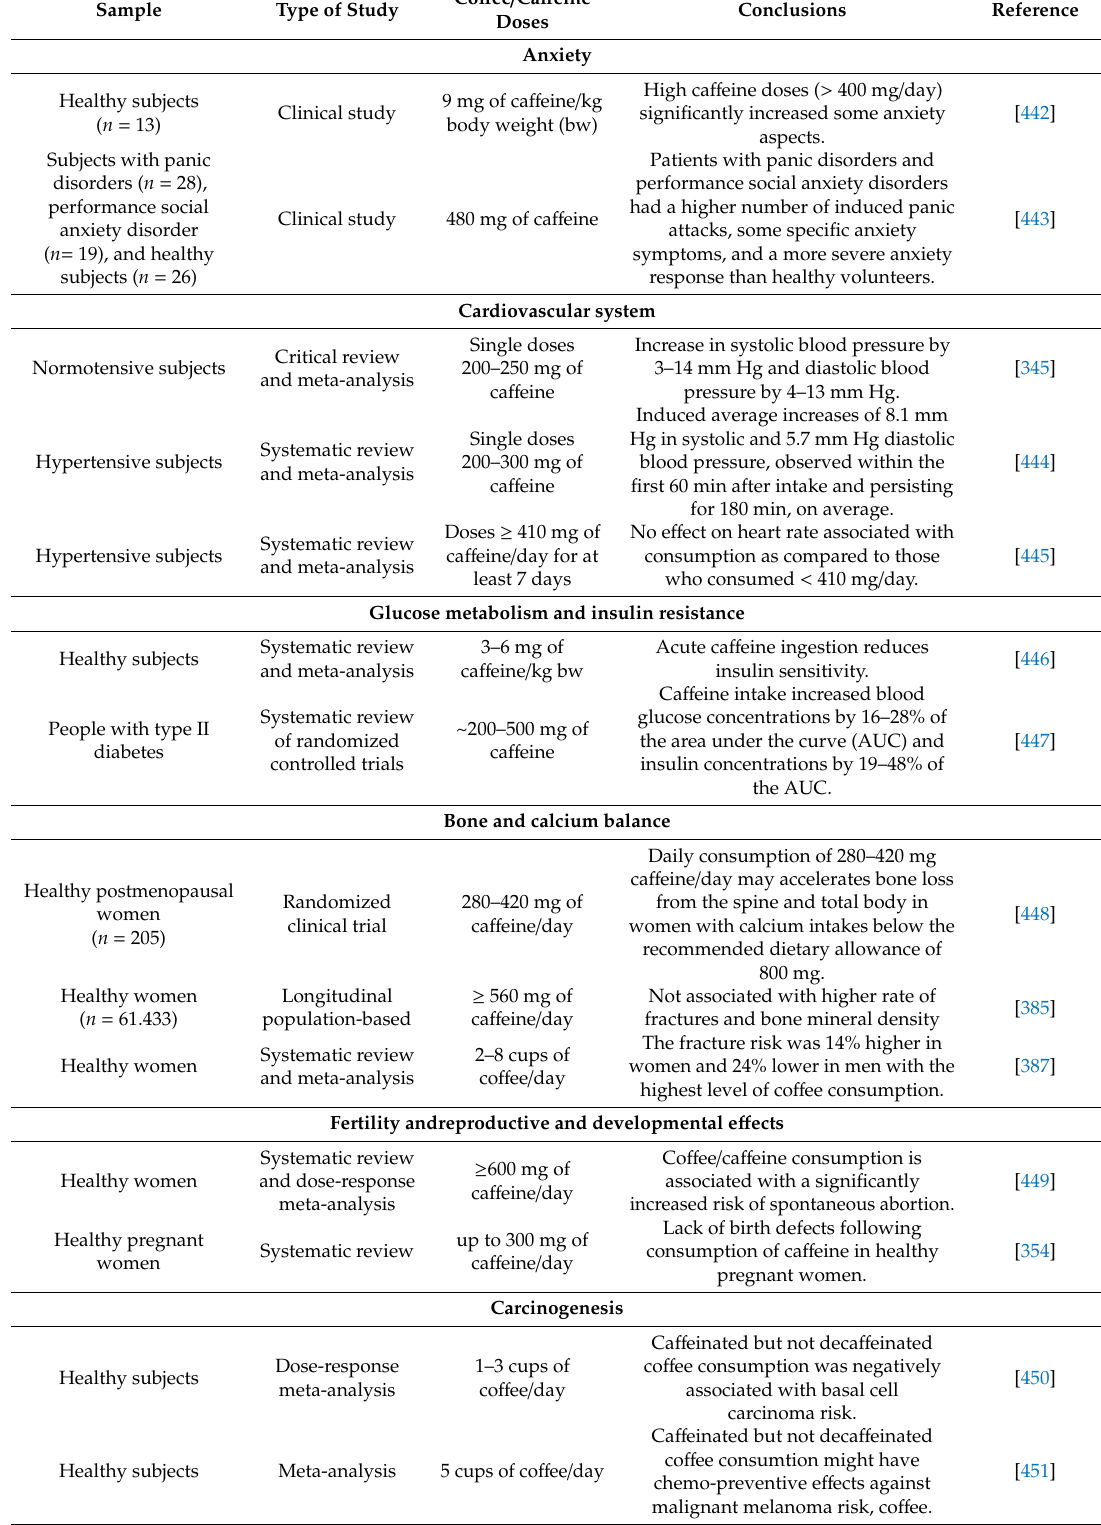
Table 4. Complementary studies on the potential adverse e ff ects of ca ff eine on